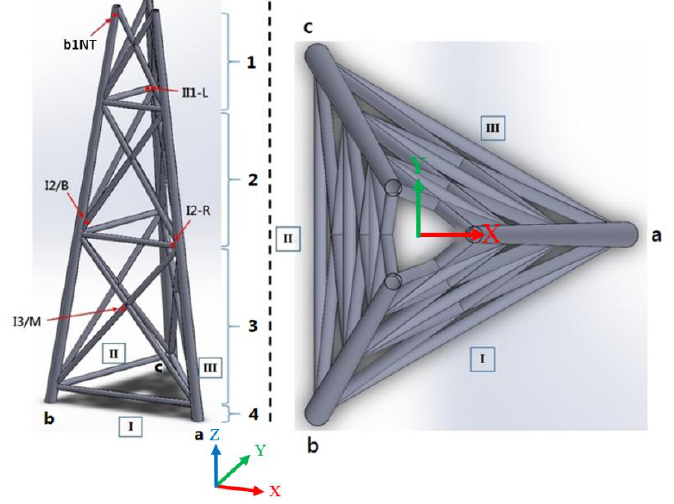
Figure A12. Four levels of abbreviations and examples used for PJ-structure members and parts.